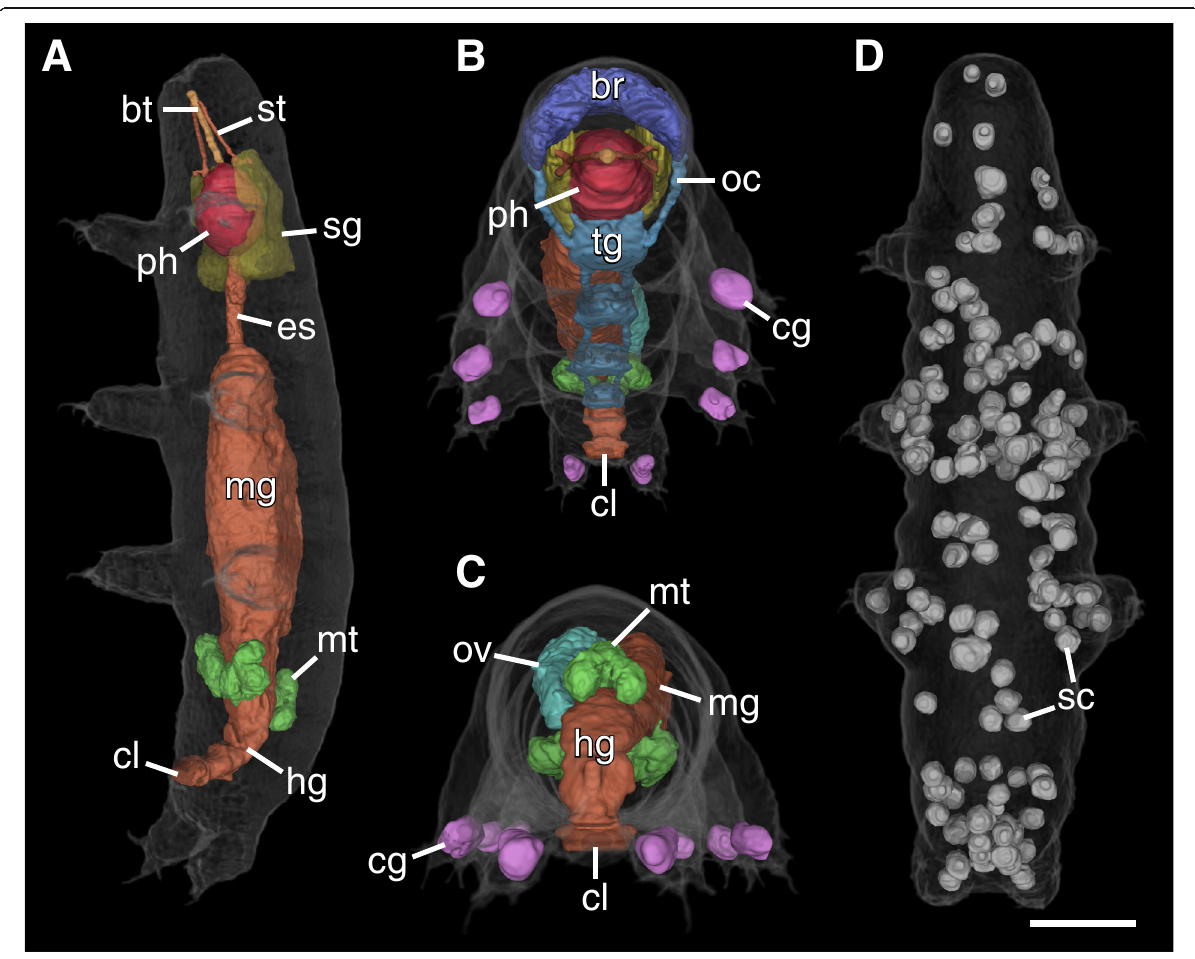
Fig. 2 3D renderings of selected structures of the tardigrade Hypsibius exemplaris . a The digestive system and associated structures. Ventrolateral view; anterior is up. The large midgut is the most prominent region of the digestive tract. Note how the large salivary glands (yellow) surround the pharynx (red). The transition between the midgut and hindgut is marked by the attachment sites of the Malpighian tubules (green). b Frontal-ventral view emphasizing the organization of the buccopharyngeal apparatus. c Posterior view showing the orientation of the ovary (teal) and Malpighian tubules (green). Notice how the ovary is located to the left of the midgut, displacing the midgut to the right side of the midline of the body. The Malpighian tubules consist of paired ventral units and an unpaired dorsal unit. d The 137 storage cells of this specimen are distributed throughout the body. Dorsal view; anterior is up. Abbreviations: bt, buccal tube; br, brain; cg, claw glands; cl, cloaca; es, esophagus; hg, hindgut; mg, midgut; mt, Malpighian tubules; oc, outer connectives; ov, ovary; ph, pharynx; sc, storage cells; sg, salivary glands; st, stylet. Scale bar: 20 μ m (for a - d